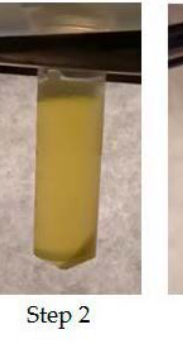
Figure 3. PTPS at Step 2 and Step 6 of the